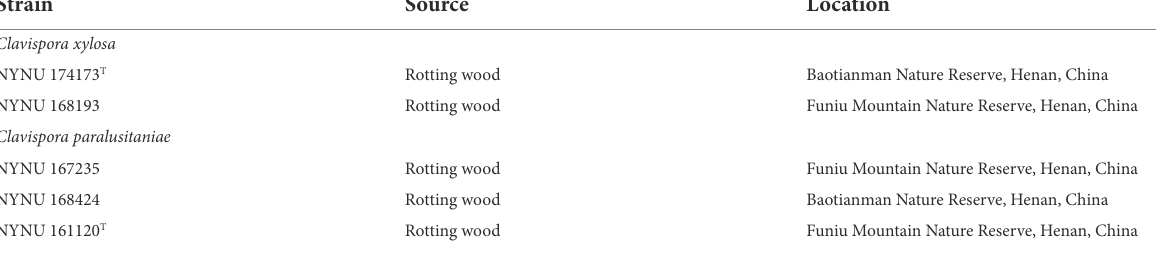
TABLE 1 Novel yeast strains isolated from rotting